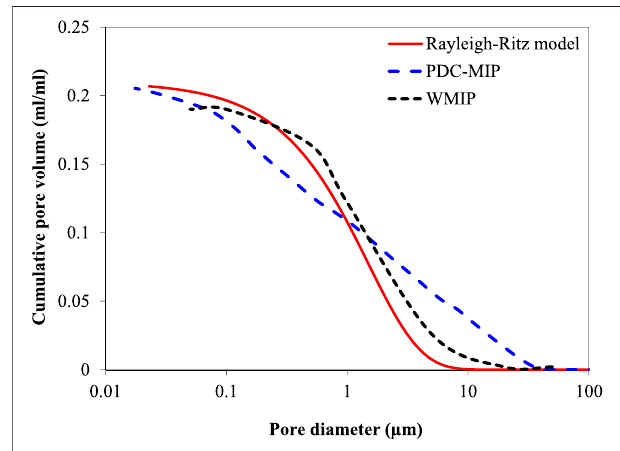
FIGURE 2| Pore size distributions simulated by the Rayleigh-Ritz model and measured by PDC-MIP [after Zhou et al. (2010)] and WMIP (after Willis et al.